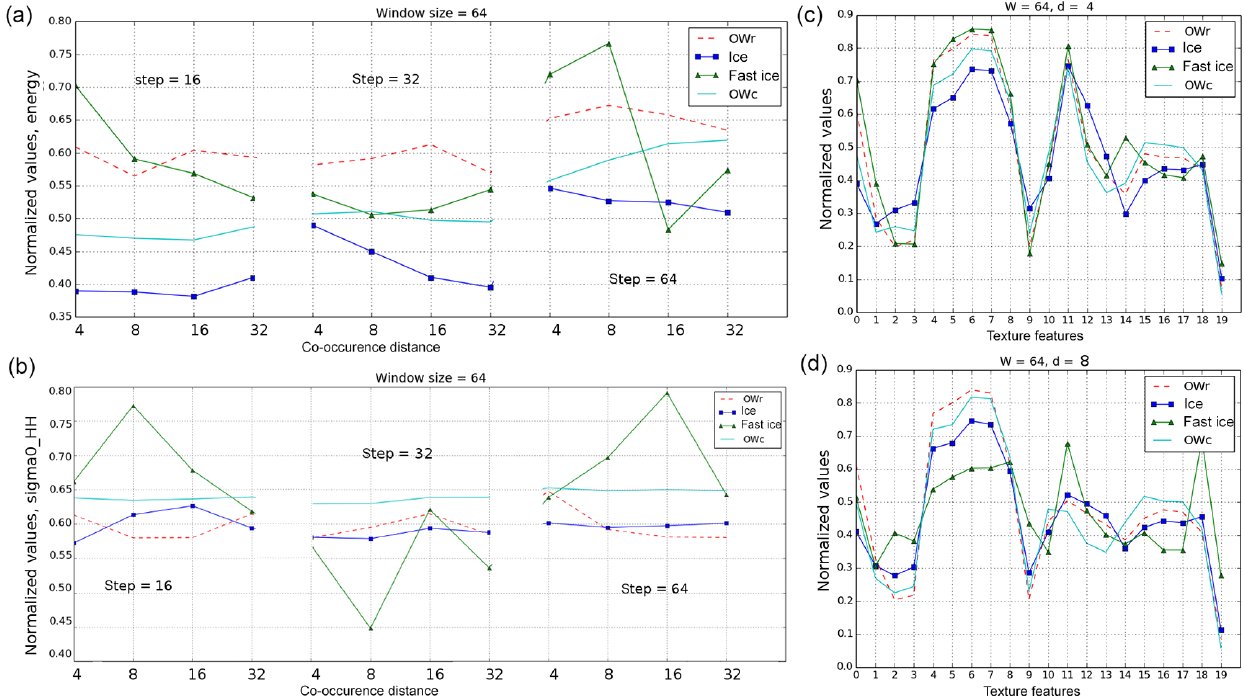
Figure 4. Normalized mean values of texture characteristics for calm open water (OWc), rough open water (OWr), ice, and fast ice, calculated in window size 64 × 64 pixels: (a) energy and (b) σ ◦ of HH with different co-occurrence distances for several moving step variations. Set of texture features are calculated with found above parameters: (c) d = 4 and step = 16; (d) d = 8 and step = 16 pixels (0 – energy, 1 – correlation, 2 – inertia or contrast, 3 – cluster prominence, 4 – homogeneity, 5 – entropy, 6 – third central statistical moment of brightness, 7 – fourth central statistical moment of brightness, 8 – average sea ice backscatter, 9 – standard deviation of brightness for HH). The range from 10 to 19 indicates the same texture features calculated for HV. The calculations were made for several images used for training. Table 2. Monthly averaged accuracies of the automatic ice charts compared to MET Norway ice charts (results given in %). 2013 Months Images Ov acc